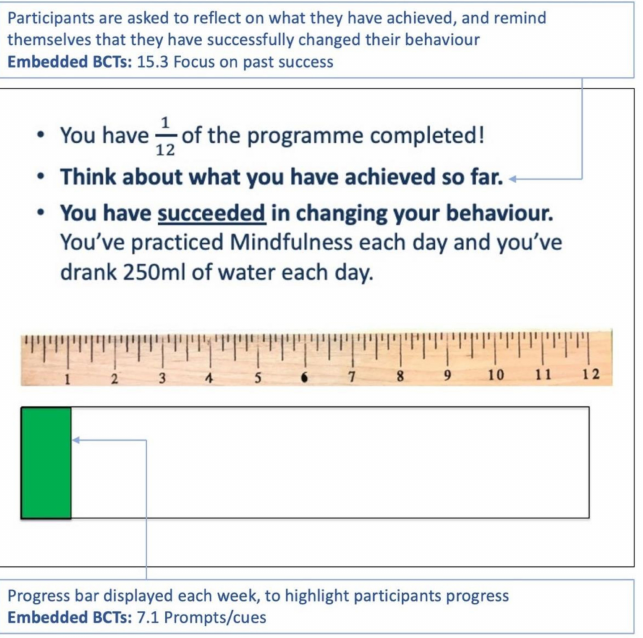
Figure 14. Week 1: The participant is given feedback/encouragement on their progress. The text in the blue boxes is explanatory text and not part of the planner. The BCTs used, refer to the Michie et al. taxonomy